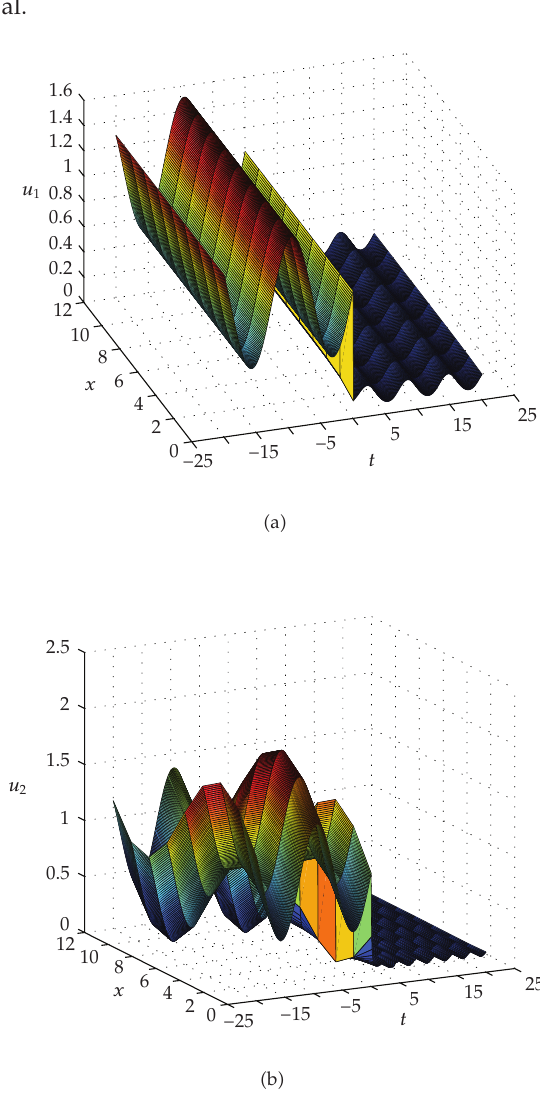
Figure 1: Numerical simulation of Example